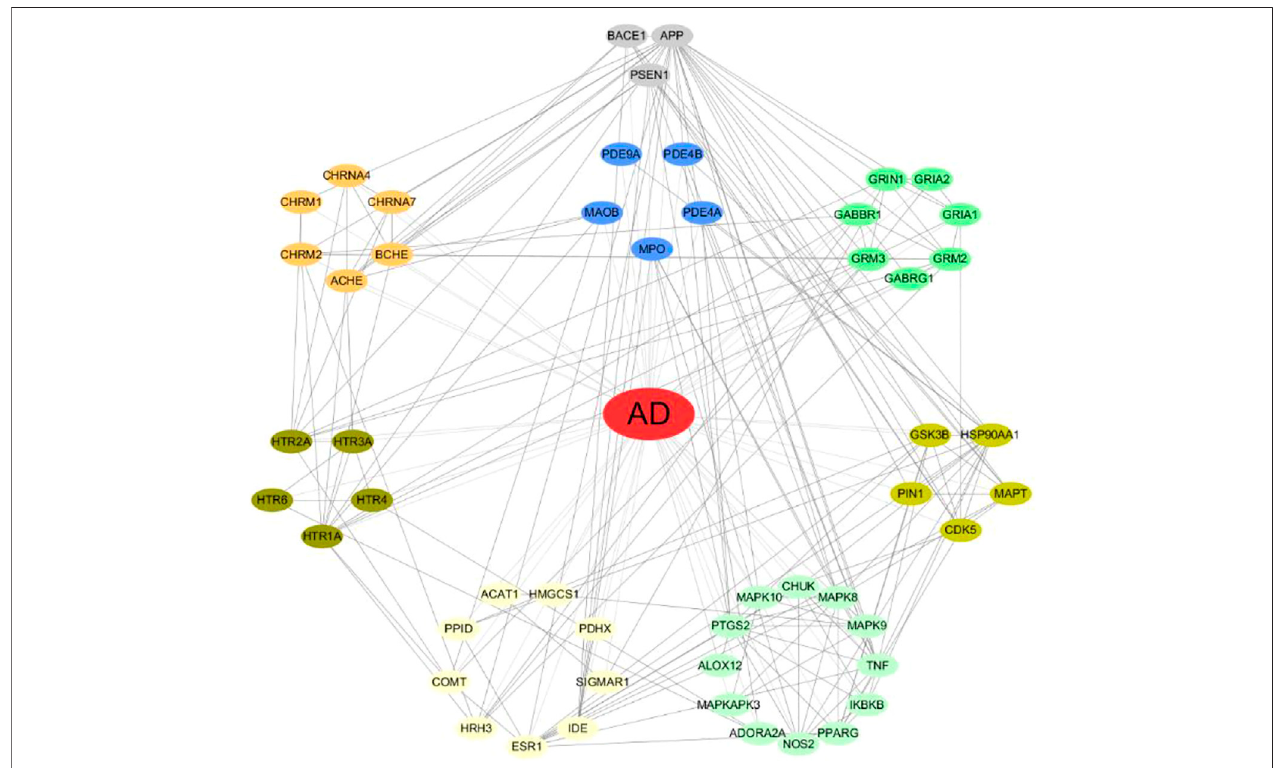
FIGURE 1 | The analysis of protein-protein interaction network of AD-related targets by